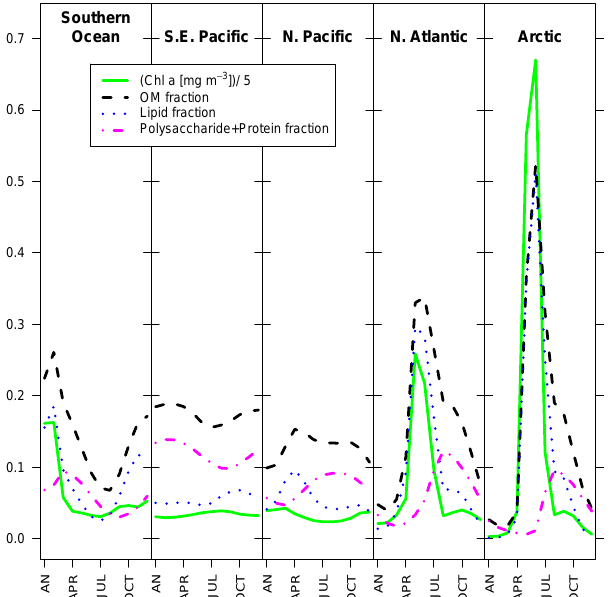
Figure 11. Monthly mean values from the BASE case for ocean regions indicated in Fig. 9. Green solid line: POP-simulated chl a (mgm − 3 ) / 5 – Note that chl a is scaled to improve legibility of seasonal trends. Black dashed line: total submicron SSA dry organic mass fraction. Blue dotted line: lipid mass fraction. Magenta dot- dash line: polysaccharide + protein mass